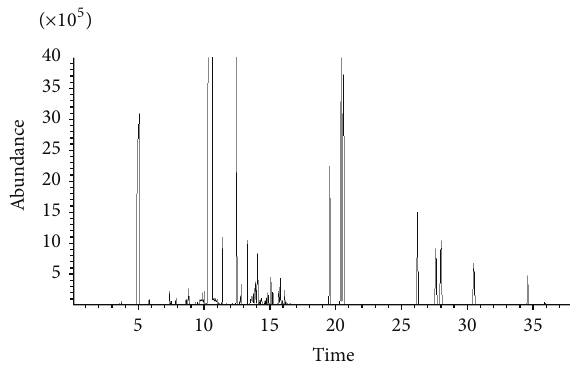
Figure 3: Typical chromatograms of volatile components from Herba Asari by